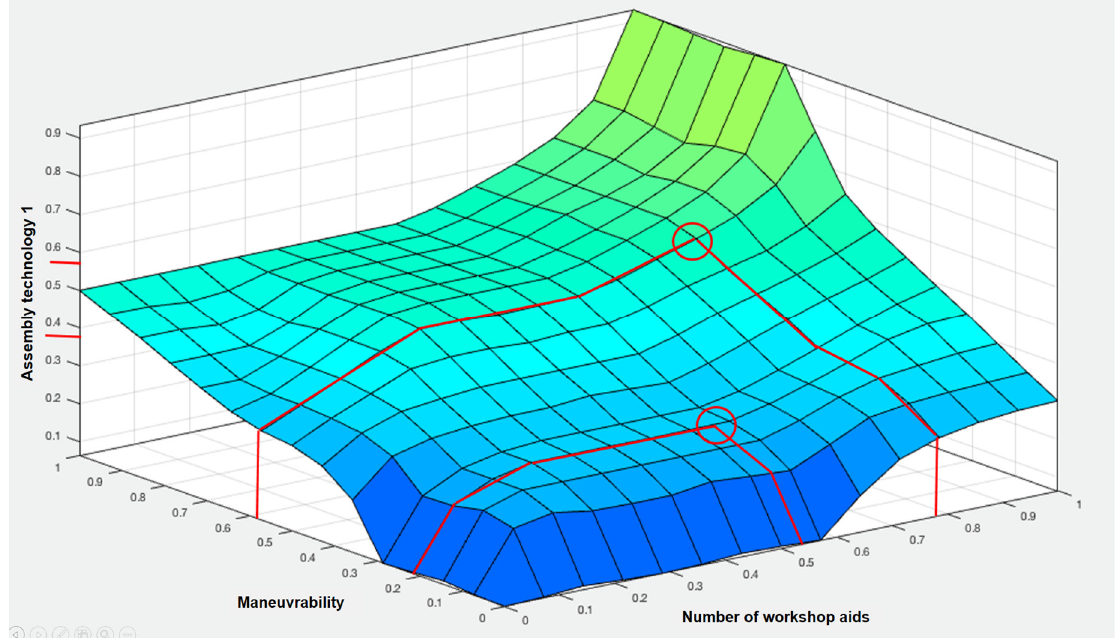
Figure 20. Surface viewer—The surface of the dependence of the variable “installation technology 1” on the input variables for “gears”.